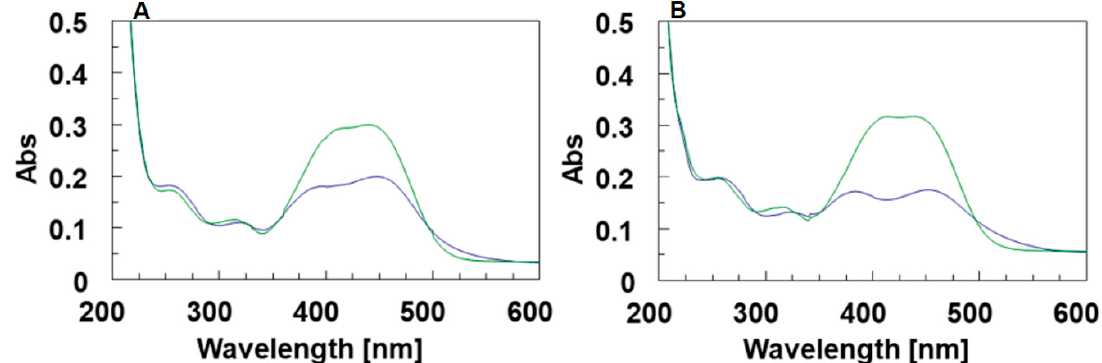
Figure 9. ( A ) UV spectra of the free DMAzo in the 5KEW containing 0.1 mM of TEA before (green line) and after (blue line) excitation with LED at 436 nm. ( B ) UV spectra of the free DMAzo in the 5KEW containing 0.5 mM of TEA before (green line) and after (blue line) excitation with LED at 436 nm.